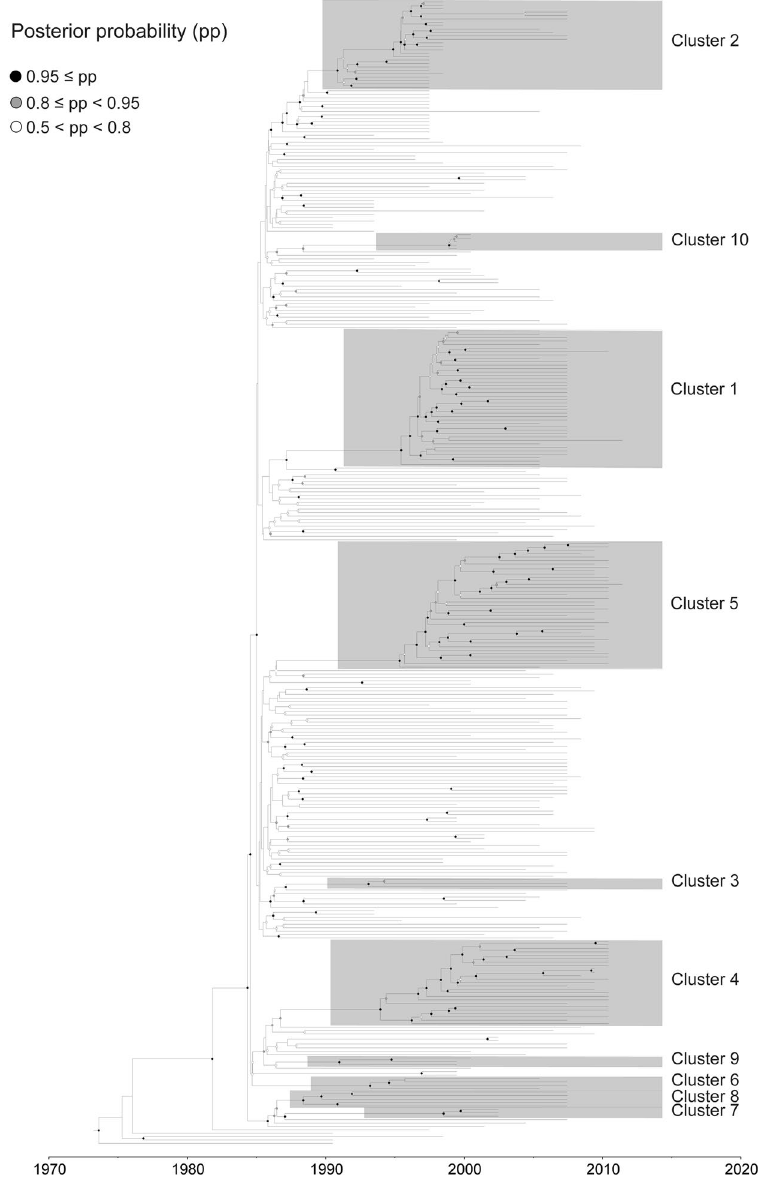
Figure 5. Maximum-clade-credibility tree estimated from near-complete genome sequences of HIV-1 CRF01_ AE. Sequence names include accession number, geographic location, and year of sampling. Only internal nodes with posterior probability support > 0.5 are shown with white, grey, and black